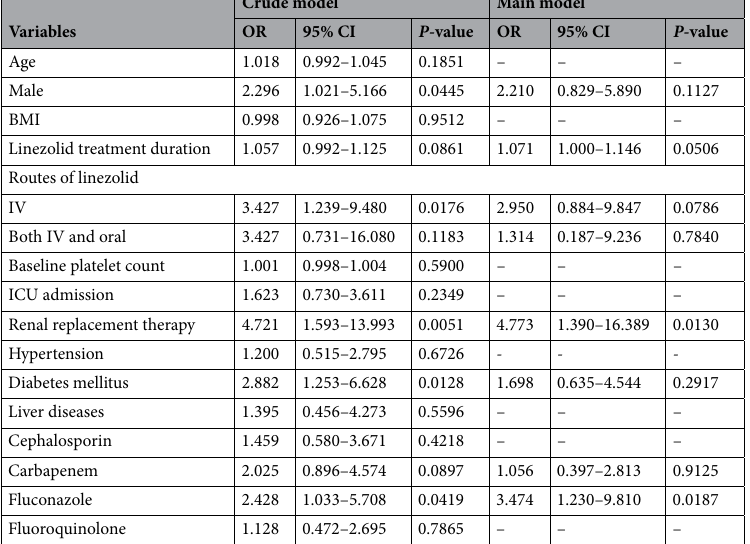
Table 2. Association between risk factors and incidence of linezolid-associated thrombocytopenia. Main model was adjusted for gender, treatment duration, routes of administration, renal replacement therapy, diabetes mellitus, concurrent carbapenem, and concurrent fluconazole therapy. BMI, body mass index; ICU, intensive care unit; IV, intravenous; CI, confidence interval.